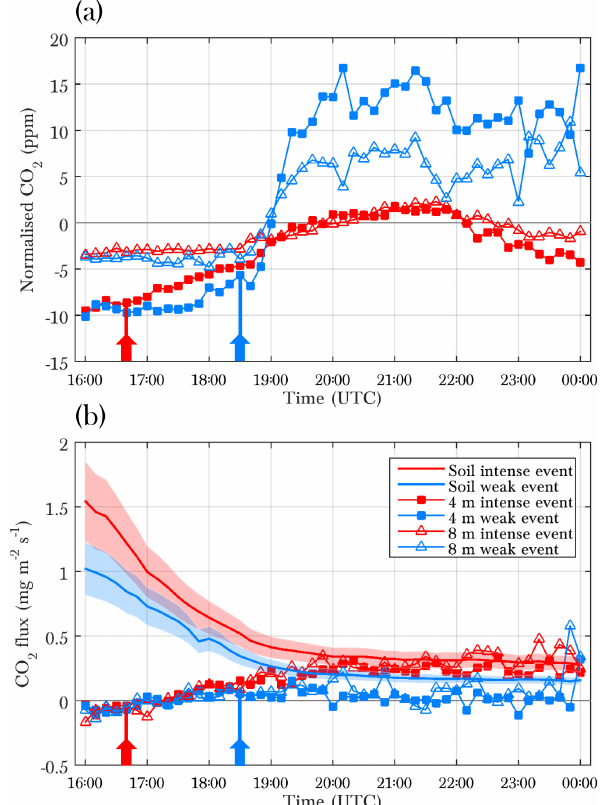
Figure 11. Time evolution of the normalised CO 2 mixing ratio (a) and vertical turbulent fluxes (b) at 4 and 8ma.g.l. for the weak (blue) and intense (red) events. In panel (b) , we include in solid lines the soil-respiration estimation and the 20% uncertainty of R 10 (see Eq. 3) in shaded. The onset of the downslope flow is indicated by faced arrows of respective